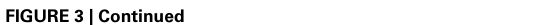
FIGURE 3 | Continued NA and DA activate the cAMP/PKA pathway in pyramidal neurons. 2-photon imaging of pyramidal neurons expressing the GAkdYmut fluorescent PKA sensor in parietal cortical slices. (A) Responses to bath application of DA, NA, and the adenylate cyclase activator FSK.Traces show the variation of fluorescence intensity measured at the soma of individual neurons indicated by arrows on pseudocolor images below. Black arrowheads indicate time points corresponding to pseudocolor